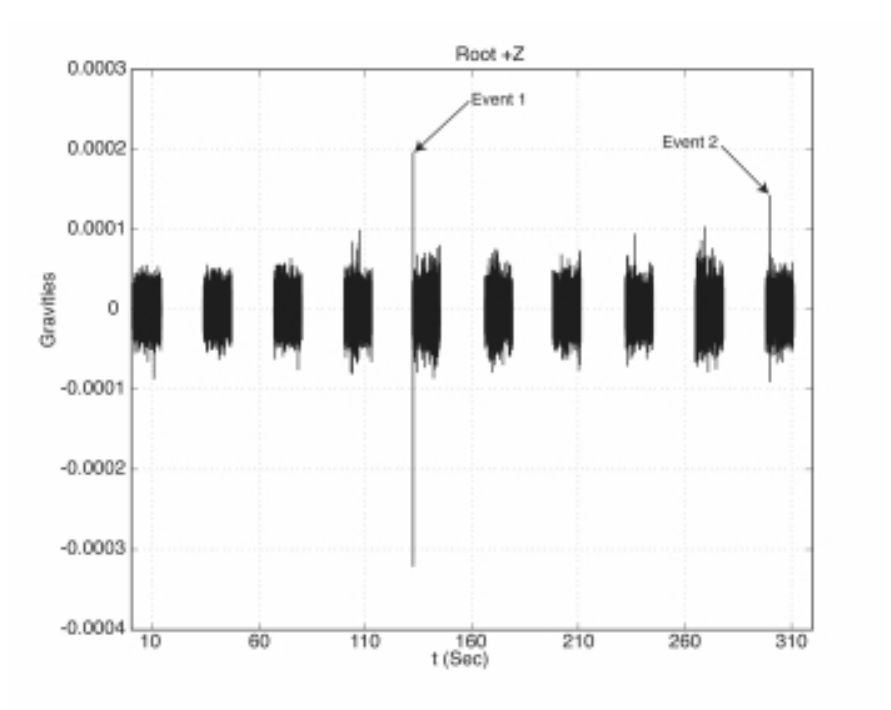
Fig. 3. Accelerometer Response during Thermal Excitation Period at Node 3004 in the Z-Direction (High-pass Filtered above 100